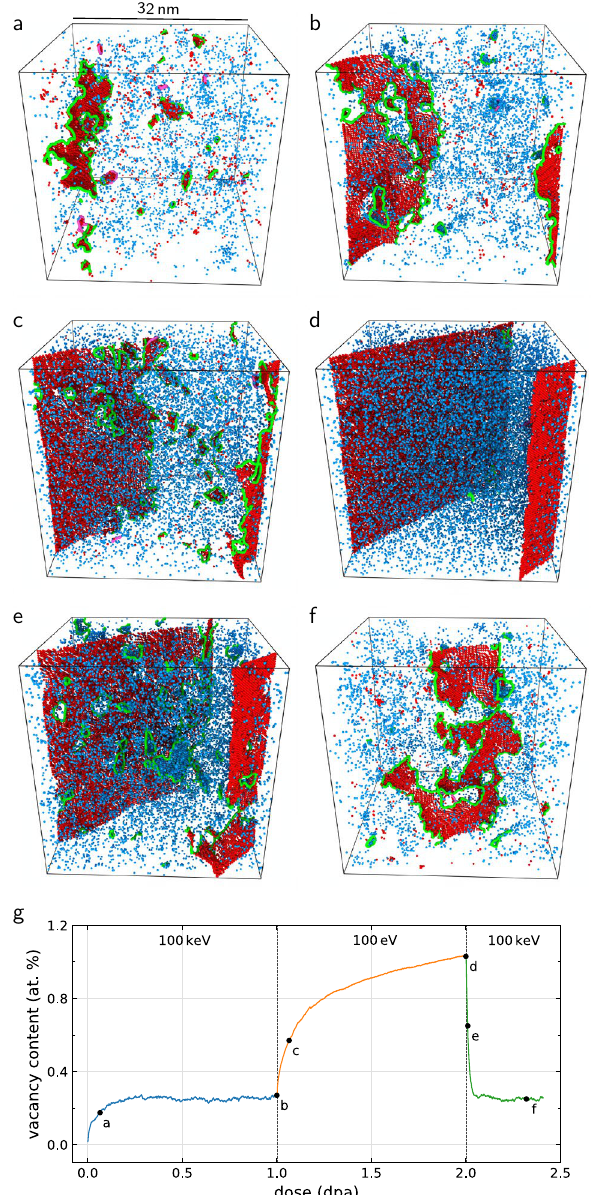
Figure 3. Reversibility of driven high-dose microstructure. ( a , b ) Pristine tungsten is damaged by 100 keV cascades until saturation. ( c , d ) Switching to 100 eV cascades drives the system towards a steady state with higher vacancy content. ( e , f ) Switching back to 100 keV cascades returns the system to the previous steady state with lower vacancy content through formation and coalescence of vacancy loops. Green (pink) lines show the position of 1 / 2 (cid:31) 111 (cid:30) ( (cid:31) 100 (cid:30) ) dislocation lines detected using the DXA method 27